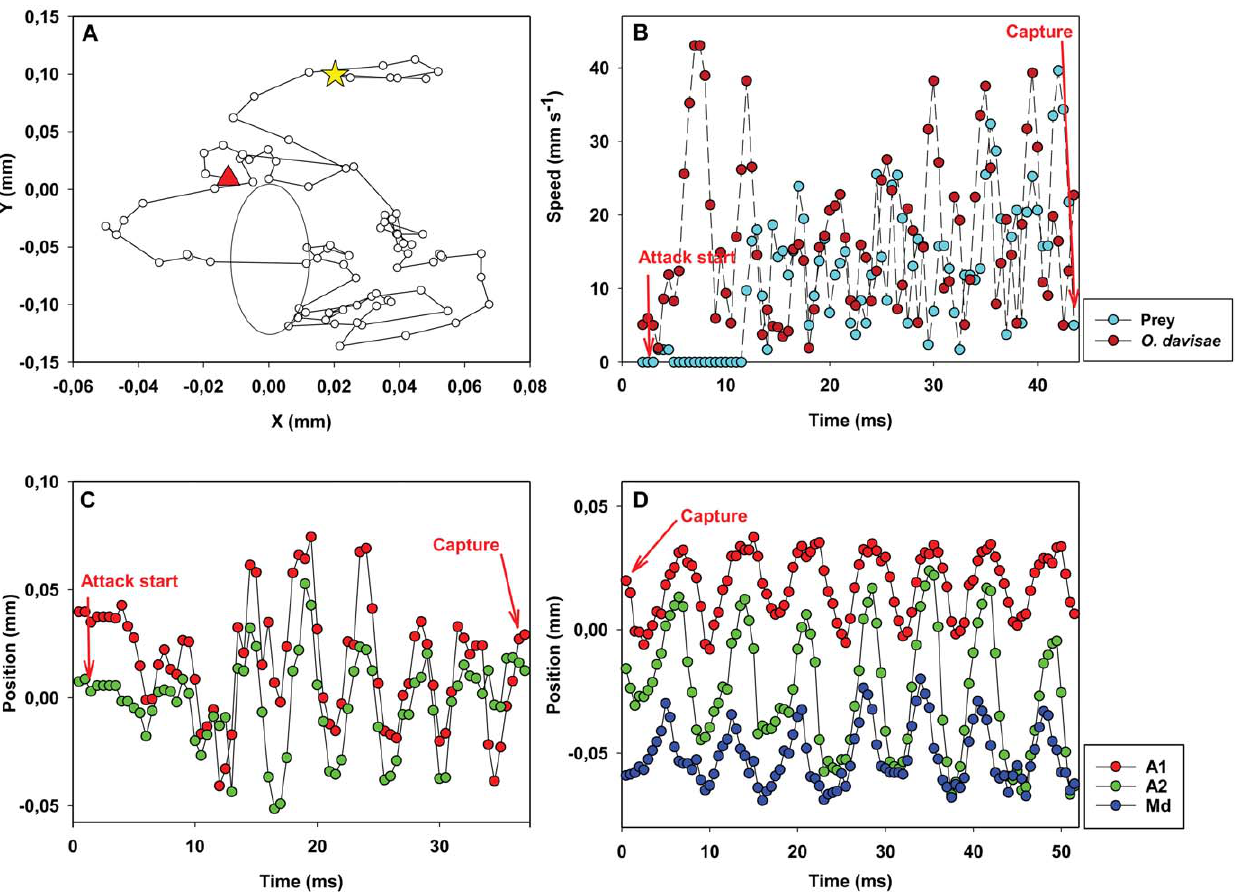
Figure 5. Oithonadavisae : example of prey captures and X-position of the appendages. Oithona davisae and its prey ( O. marina ). (A) Position of prey (circles) relative to the nauplius (the big oval) from detection of the prey (star) till the prey has disappeared from view and is captured (triangle). Time interval between dots: 0.5 ms. The change in relative position of the prey is due to the combined effect of the nauplius moving forward and the prey being pushed away; the prey does not swim significantly during the attack. (B) Velocity of prey and predator as a function of time. C,D.Temporal variation in X-position of appendages during prey capture (capture # 3) (C) and prey handling (capture # 7) (D).